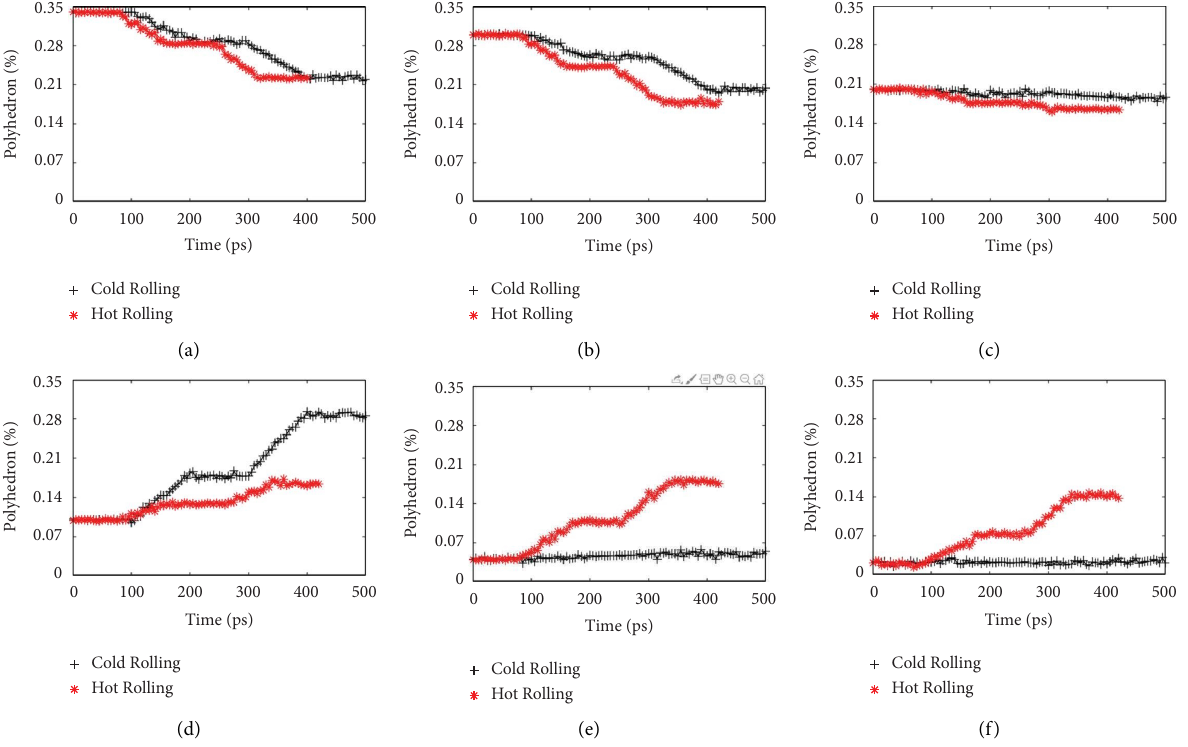
Figure 5: Fraction of main polyhedrons as a function of rolling time for (a) < 0 012 0 > (b) < 0 2 81 > (c) < 01 10 2 > , (d) < 0 3 6 3 > , (e) < 0 4 4 5 > and (f) < 0 4 4 6 > .